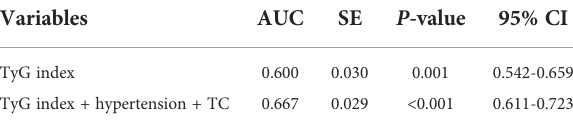
TABLE 4 Areas under the receiver operating characteristic curve (AUC) for AF in all subjects.